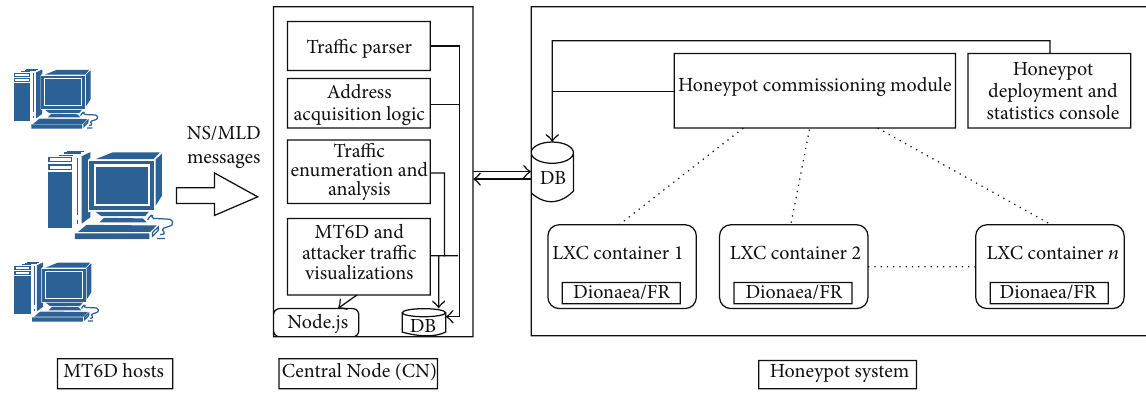
Figure 2: Solution